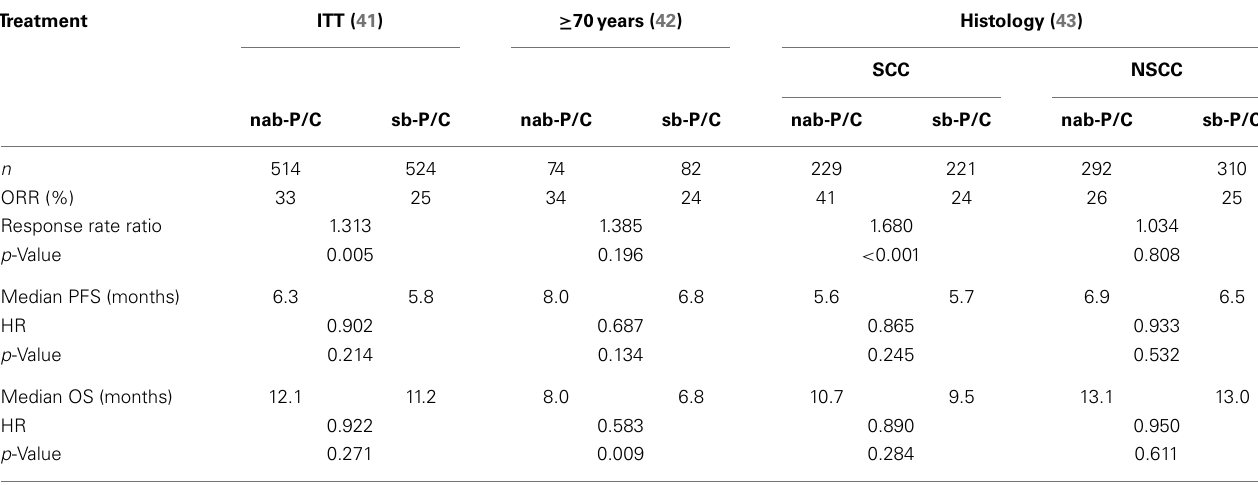
Table 2 | Select efficacy outcomes from the Phase III trial of nab-paclitaxel plus carboplatin in NSCLC .